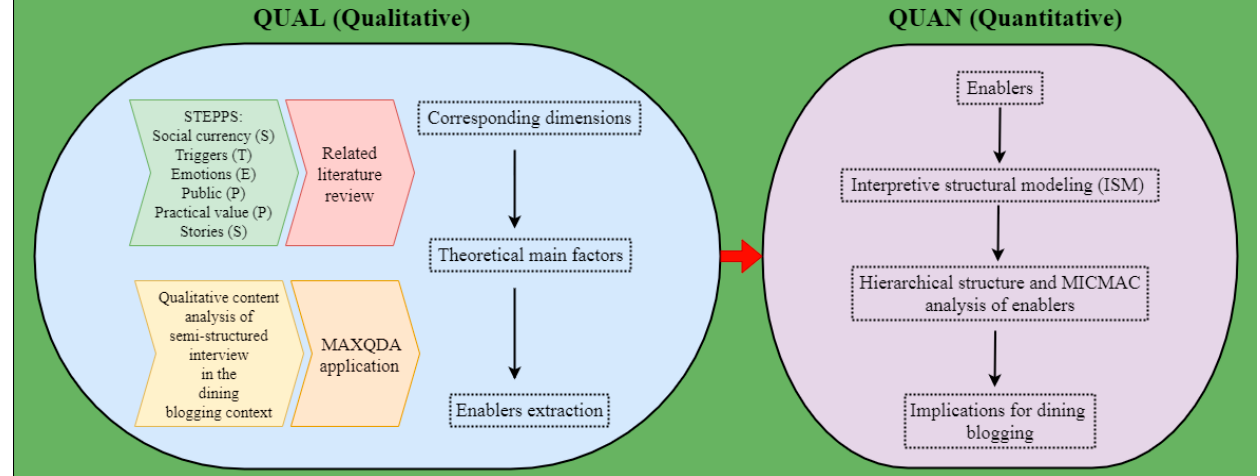
Figure 1. The originality of the research model. Table 1. Examples of mapping interview questions in the dining blog context.